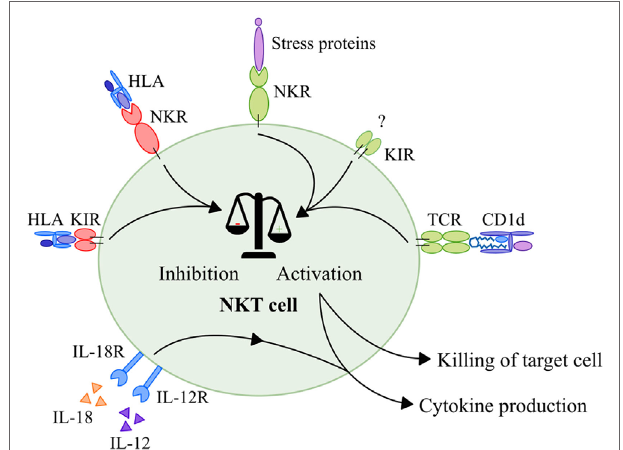
FigURe 3 | Activation of NKT cells. Activation of NKT cells is dependent on a balance between activating and inhibitory signals. First of all, NKT cells receive activating signals via their TCR that recognize glycolipids in context of CD1d. Second, NKT cells receive activating signals in a CD1d-independent manner via NKRs upon interaction with stress proteins such as MIC-A and MIC-B, ULBPs, Nectin-2, or MLL5 proteins. In addition, NKT cells receive activating signals in a CD1d-independent manner via KIRs with merely unknown ligands. Inhibitory NKRs and KIRs that recognize HLA molecules provide inhibitory signals that are able to disrupt both TCR and NKR signaling. When the balance is skewed toward activation, NKT cells produce and secrete high amounts of cytokines. In addition, NKT cells that are activated via this mechanism are able to kill target cells directly via activation of their TCRs and NKRs. Finally, NKT cells—like NK cells—can be activated by a combination of IL-12 and IL-18 which leads to production of cytokines. Abbreviations: NKT, natural killer T; TCR, T cell receptor; NKR, natural killer receptor; MIC, major histocompatibility complex I-like molecules; ULBP, unique long-binding protein; MLL5, mixed-lineage leukemia-5; KIR, killer-cell Ig-like receptor; HLA, human leukocyte antigen; NK, natural